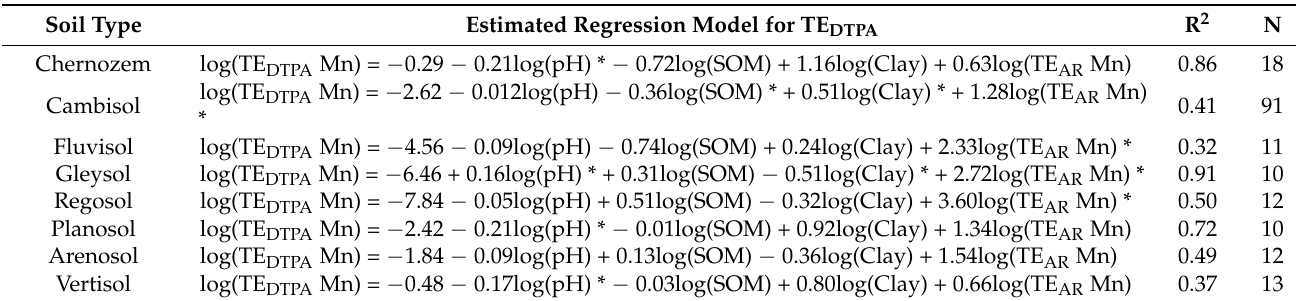
Table 7. Prediction model 4.